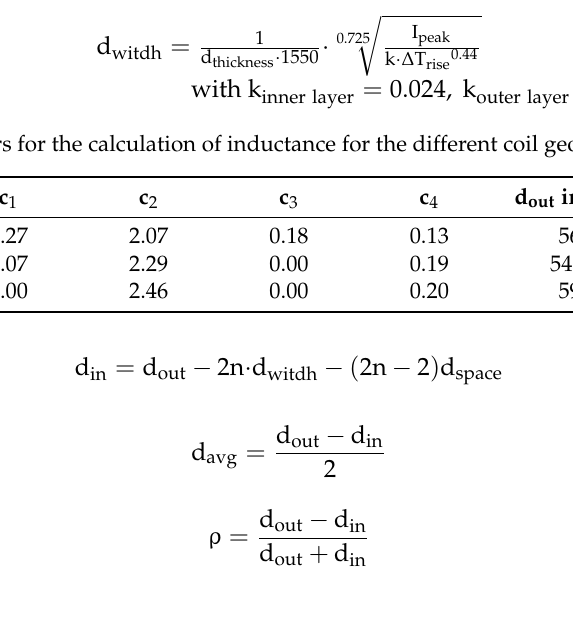
Table A2. Operating parameters of the ultra-high resolving power